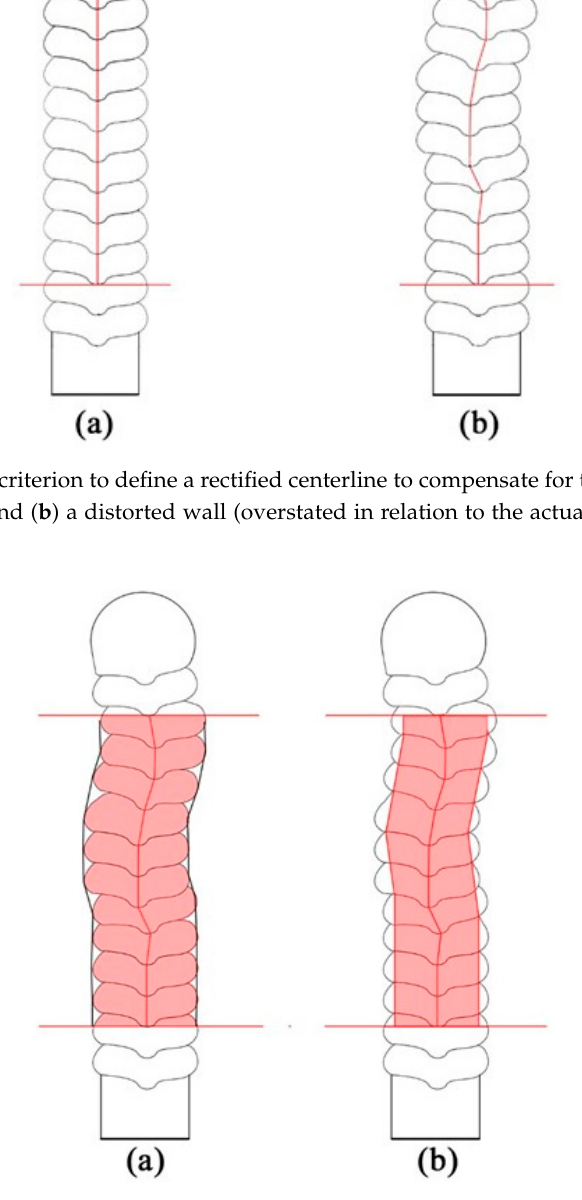
Figure 10. Subjective criterion to define the full and effective widths and cross-section areas by following the rectified centerline to compensate for the Z -axis deviations: ( a ) full area; and ( b ) effective area (overstated distortion in relation to the actual walls to emphasize the differences).